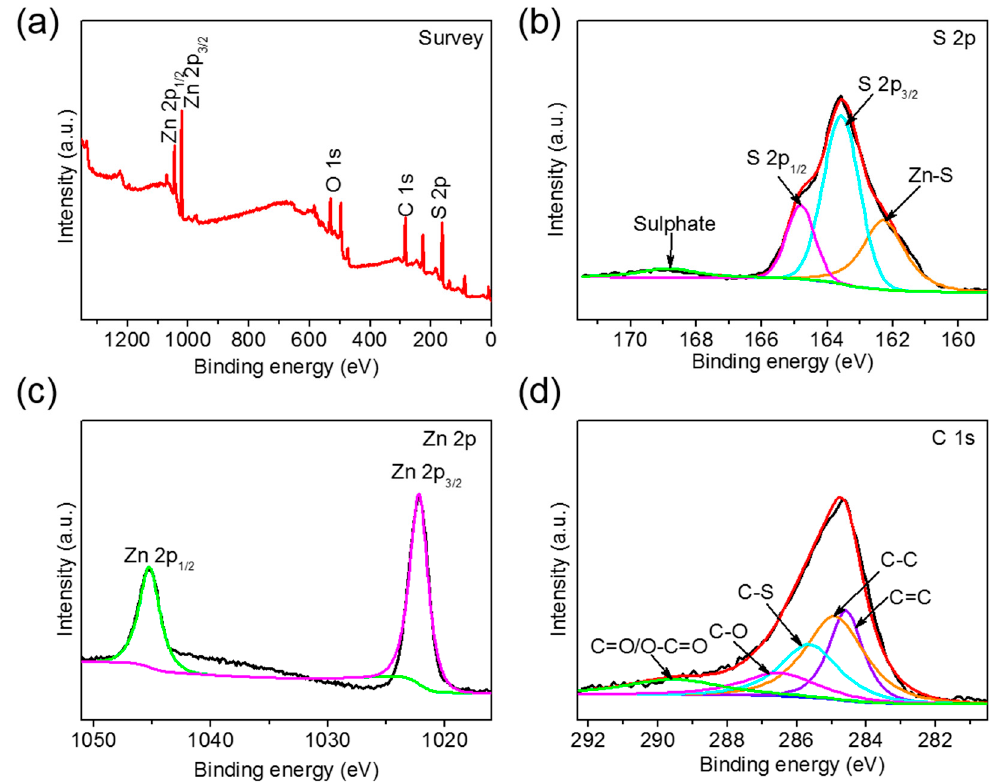
Figure 8. ( a ) XPS full spectrum, ( b ) S 2p (The orange peak at 162.1 eV, blue peak at 163.6 eV, purple peak at 164.8 eV, and green broad peak at 168.8 eV correspond to Zn-S, S 2p3/2, S 2p1/2 and sulfate bonds, respectively.), ( c ) Zn 2p (The purple peak at 1022.7 eV and the green peak at 1045.7 eV correspond to Zn 2p3/2 and Zn 2p1/2.) and ( d ) C 1s of S-3D-ZnO/rGO composite.